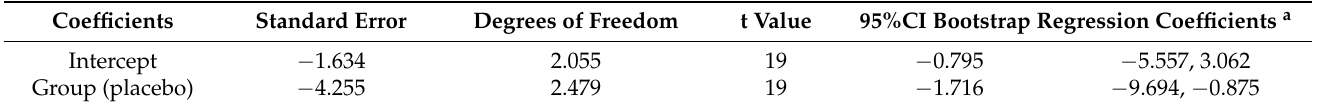
Table 8. Linear mixed model.